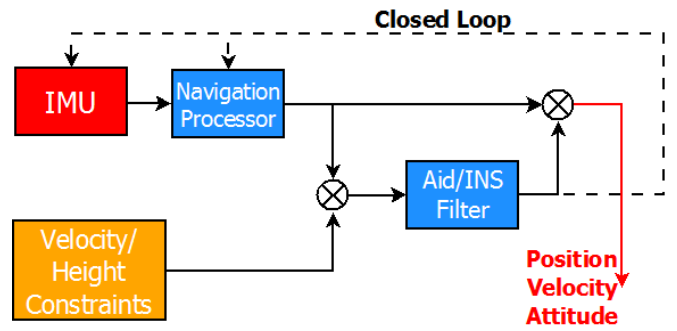
Figure 3. Velocity/height constraints aiding